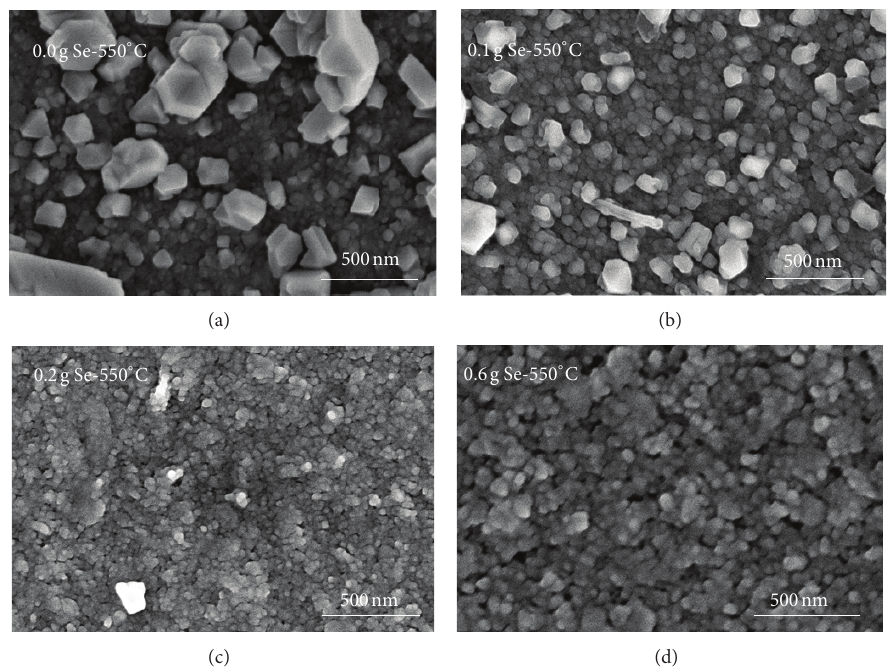
Figure 6: Surface morphologies of the CIS absorber layers as a function of extra Se content, the selenization temperature was 550 ∘ C.